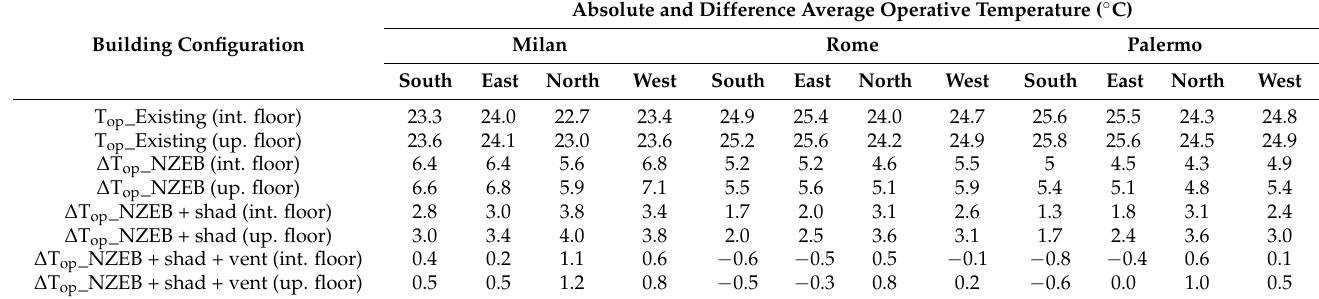
Table 5. Average operative temperature in the classrooms.